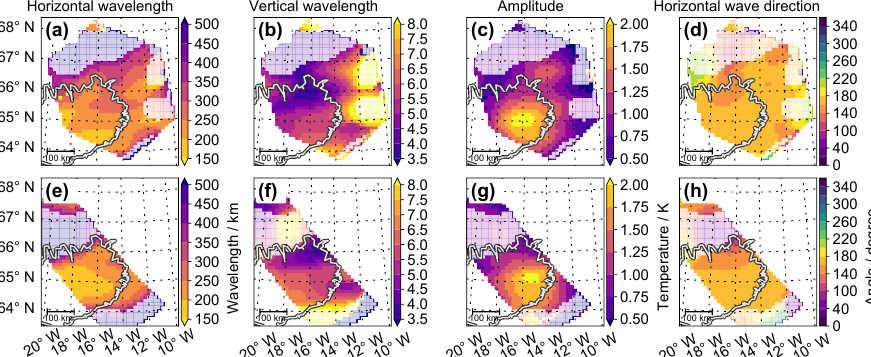
Figure 12. Wave parameters as obtained from the S3D fit with fitting cubes of 160km × 160km × 3 . 6km at a centre height of 11.5km for FAT (a–d) and LAT (e–h) . Non-significant fitting results with wavelengths above 2.5 times the cube size are shaded. Panels (a) to (d) are adapted from Krisch et al. (2017, Fig.